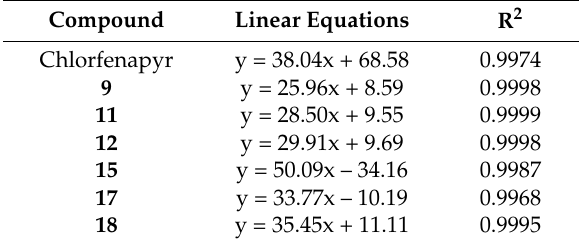
Table 6. The linear equations of the